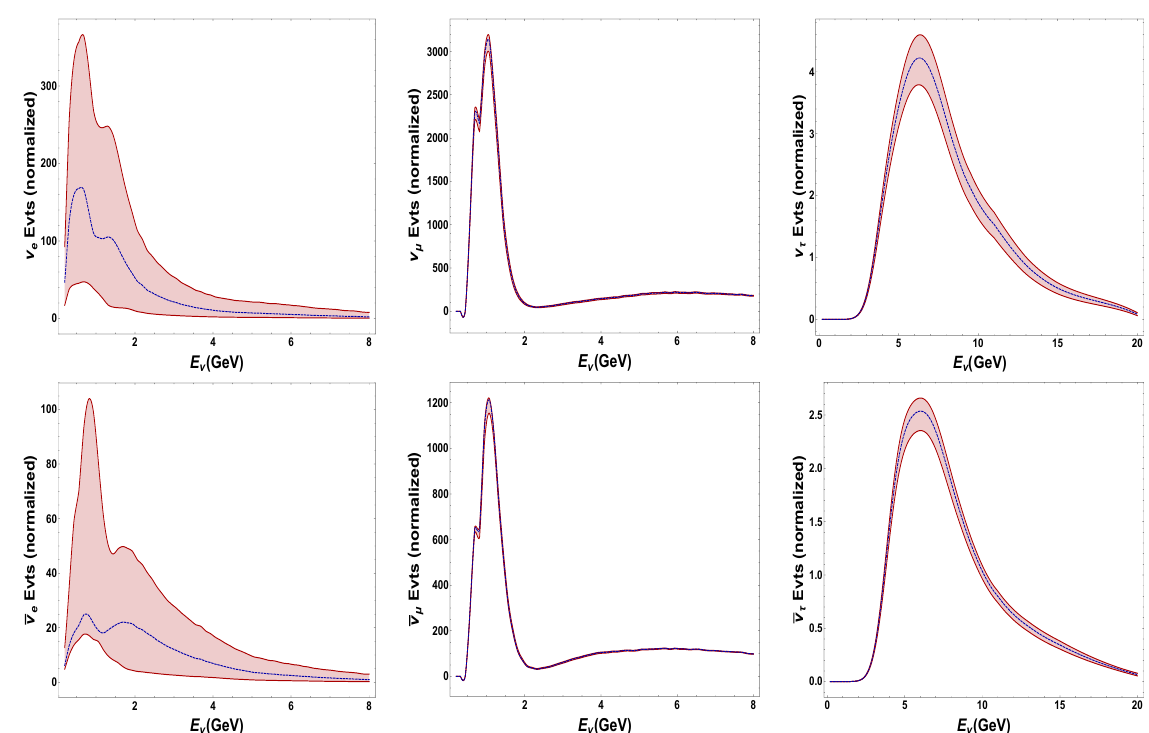
Figure 1. Expected number of neutrino (upper panels) and antineutrino (lower panels) events at the DUNE far detector as a function of the neutrino energy. The (orange) bands show the effects of including the NSI parameters in the transition probabilities; the blue dashed line refers to the spectra obtained in the standard model. The best fits for the standard oscillation angles and phase and mass differences are taken from [2] and reported in Table 3. Standard fluxes for neutrinos have been used.